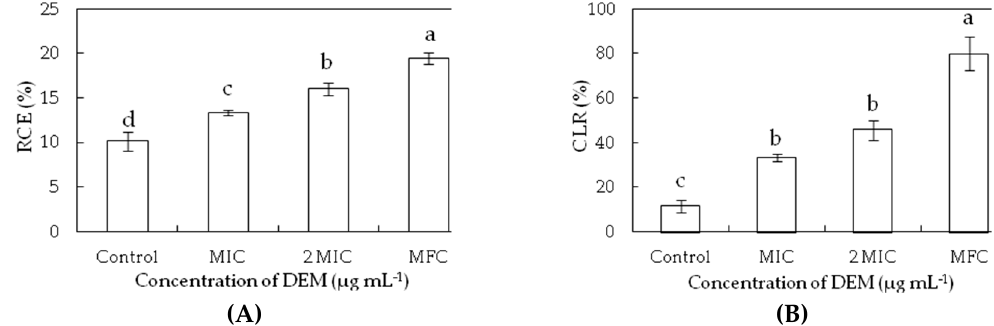
Figure 3. Effect of DEM on relative electric conductivity ( A ) and cell lysis rate ( B ) of P. italicum .